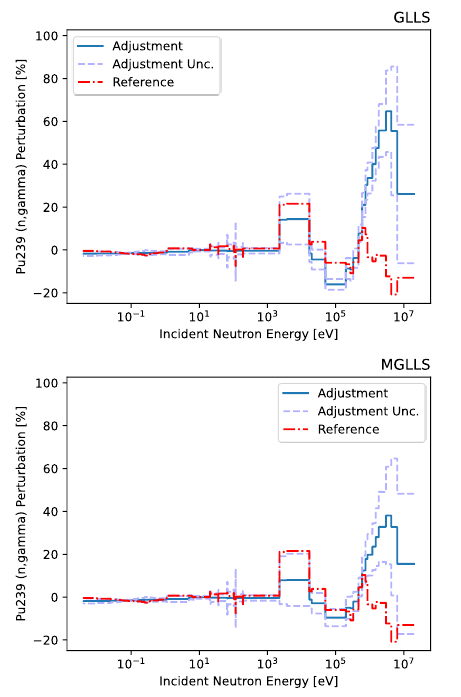
Fig. 10 Comparison of adjusted nuclear data